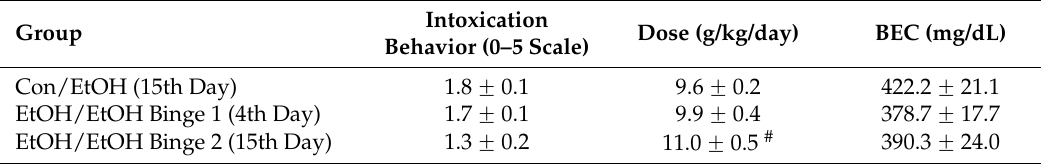
Table 2. Alcohol Model